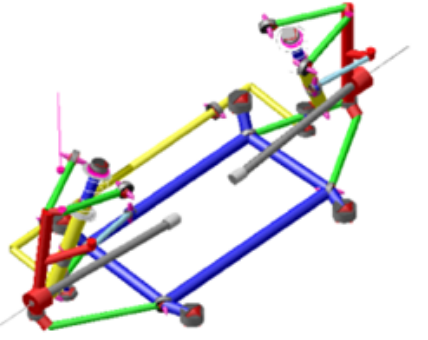
Figure 14. CAD representation of the front wheel-axle unit of the modeled Audi A6.